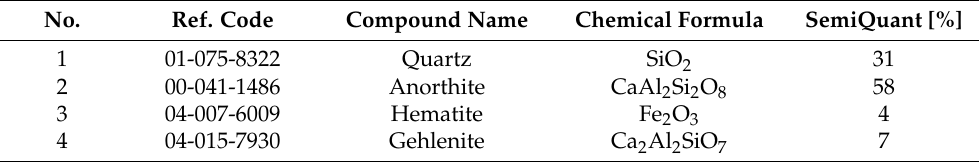
Table 1. Semi-quantitative analysis as determined by